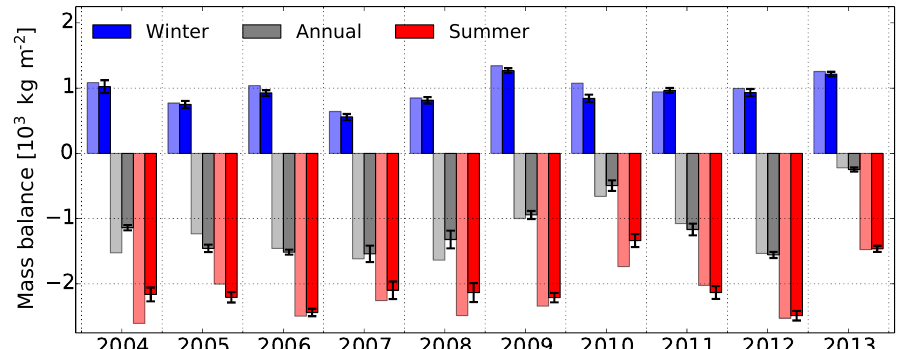
Figure 8. Original and reanalyzed seasonal mass balances at Langenferner during the study period. Error bars account for random uncertain- ties of the reference method as calculated in this study.